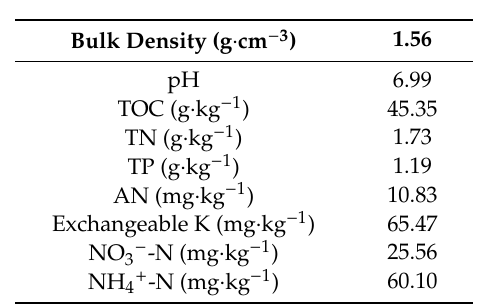
Table 1. General soil properties of the experimental site (0–20 cm) before initiation of the experiment in 2016.